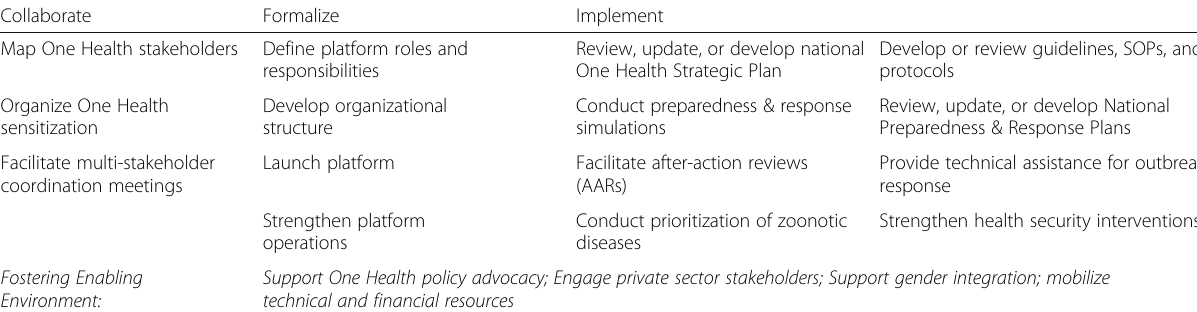
Table 1 Main Elements of the Conceptual Framework - Establishing National One Health Platforms Collaborate